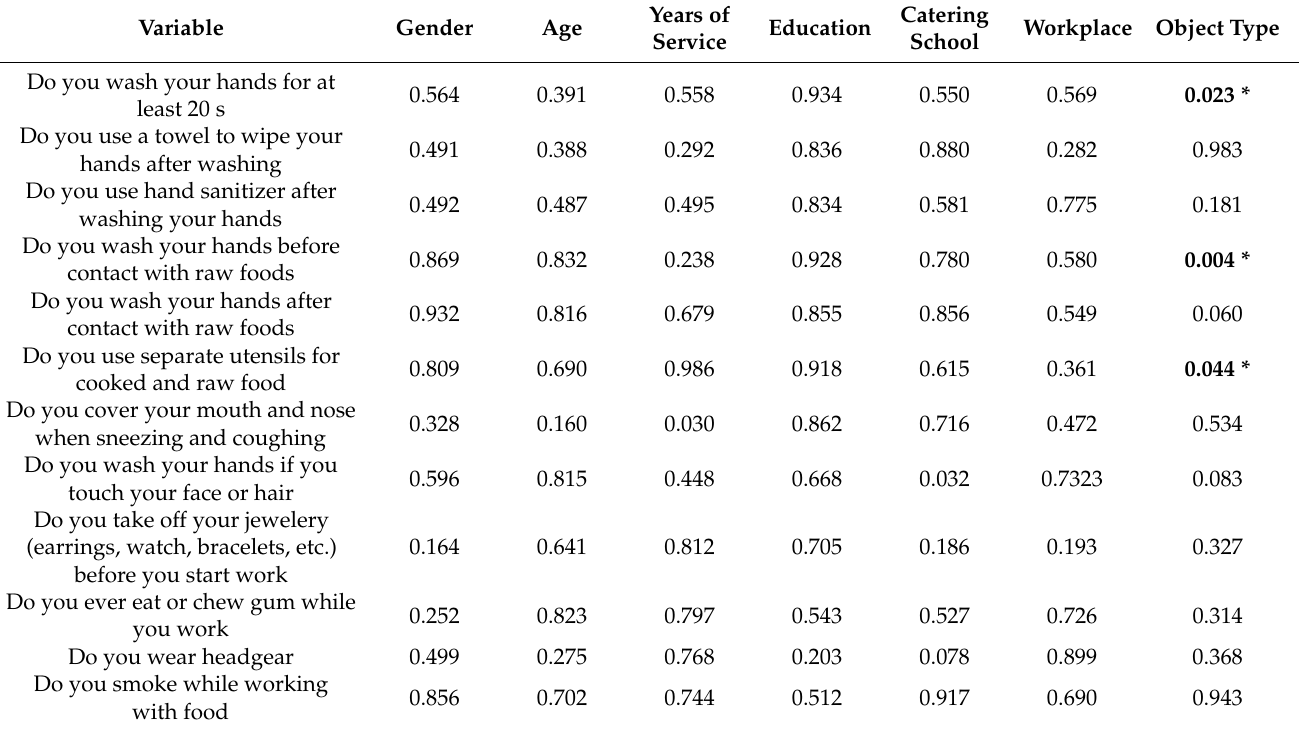
Table 3. Behaviour of participants in relation to gender, age, years of service, and education.